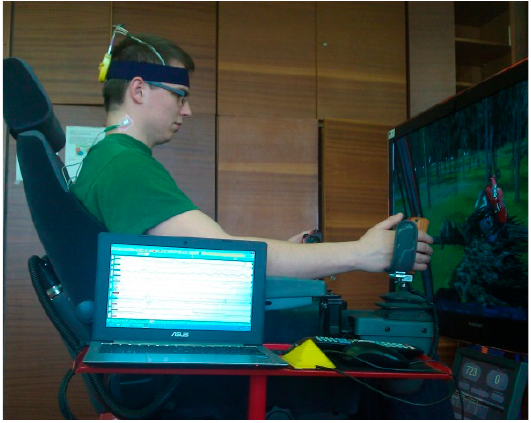
Figure 1. Harvester simulator work station.